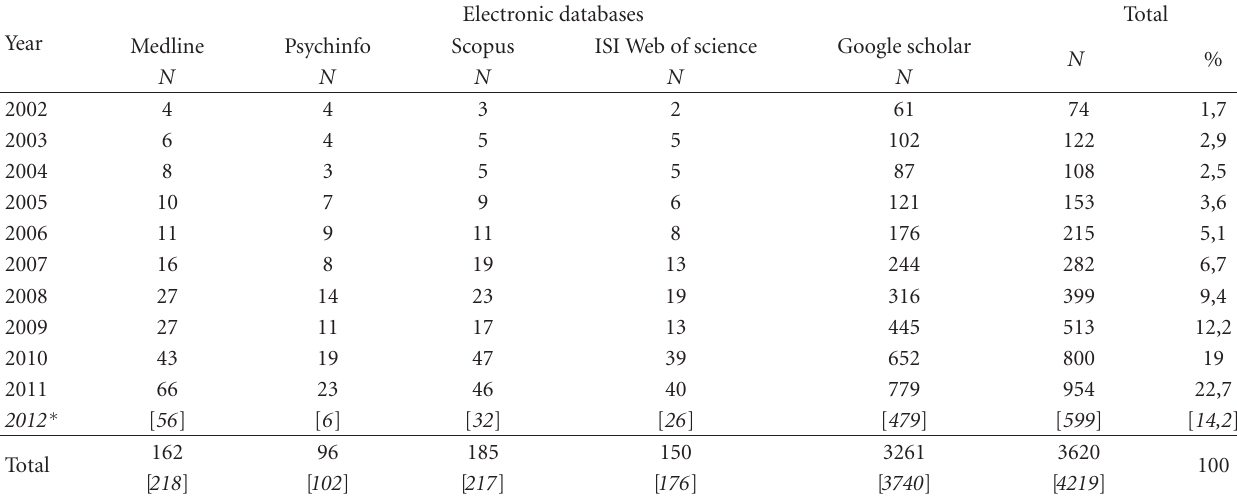
Table 1: Number of publications across years and databases.